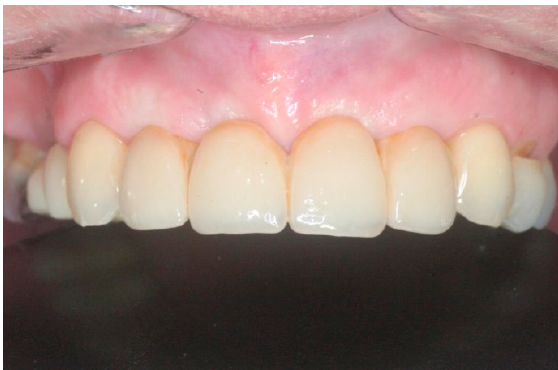
Figure 8. Fixed partial zirconia bridges (patient #29).